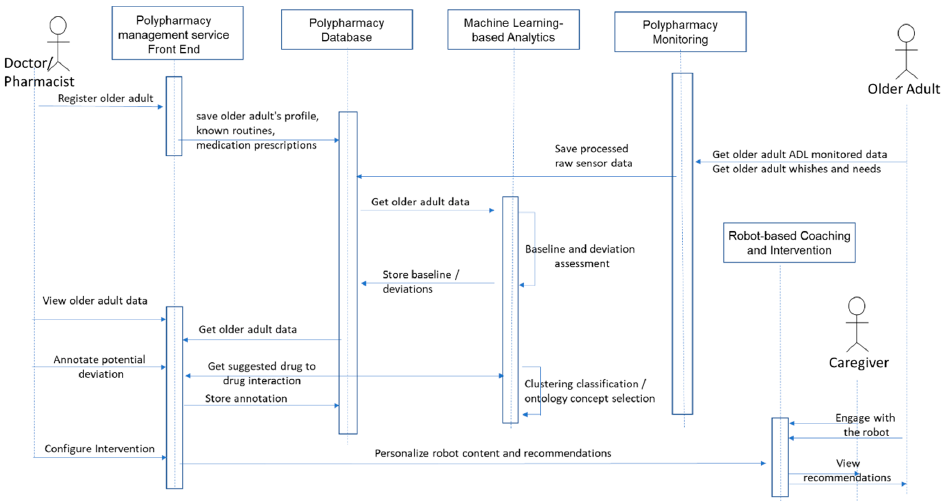
Figure 4. End-user interactions and data flows among modules of the polypharmacy management Figure service.